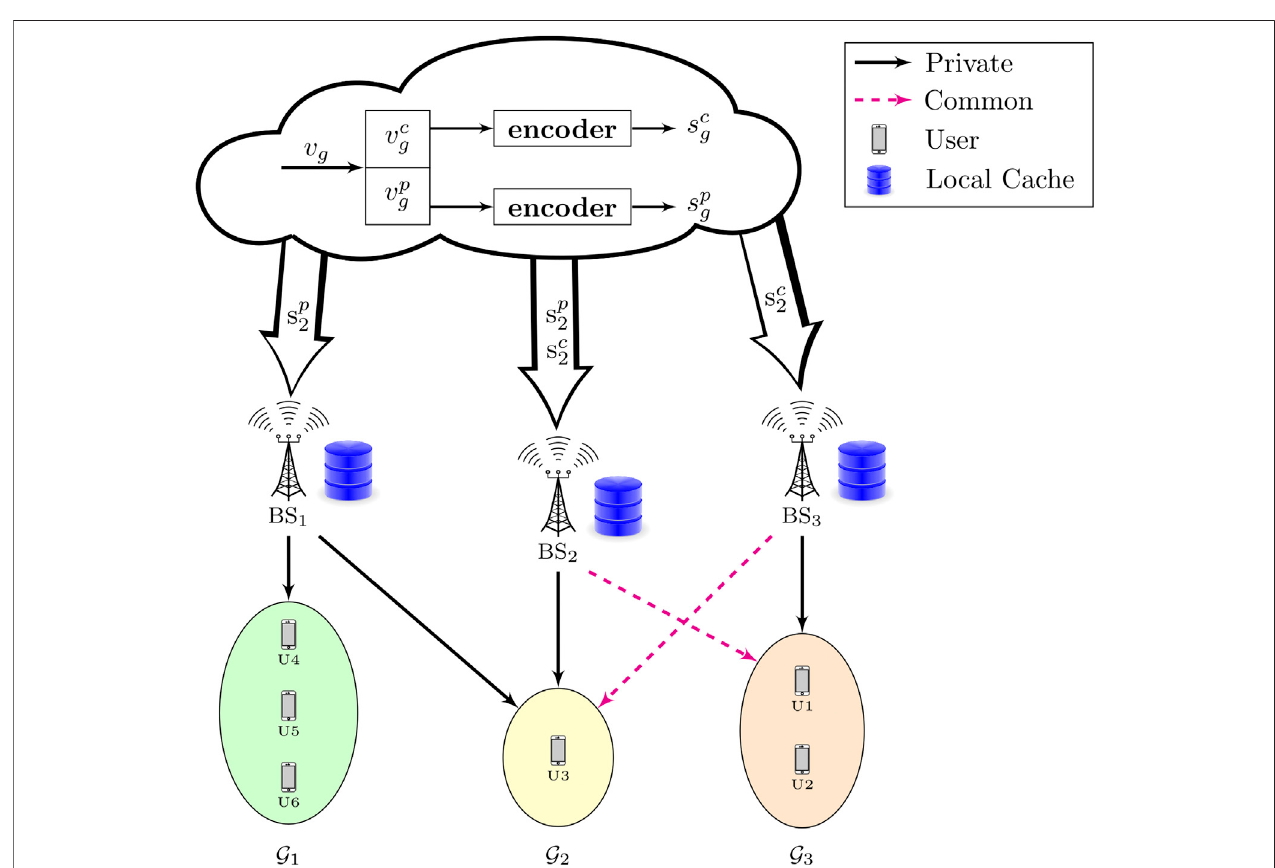
FIGURE1| AC-RANsystemwiththreeBSsservingthreegroupsofuserswithmulticastmessages.Privateandcommonmessagesareencodedatthecloud.Asa simple illustration, we show the shared private and common streams of group G 2 .